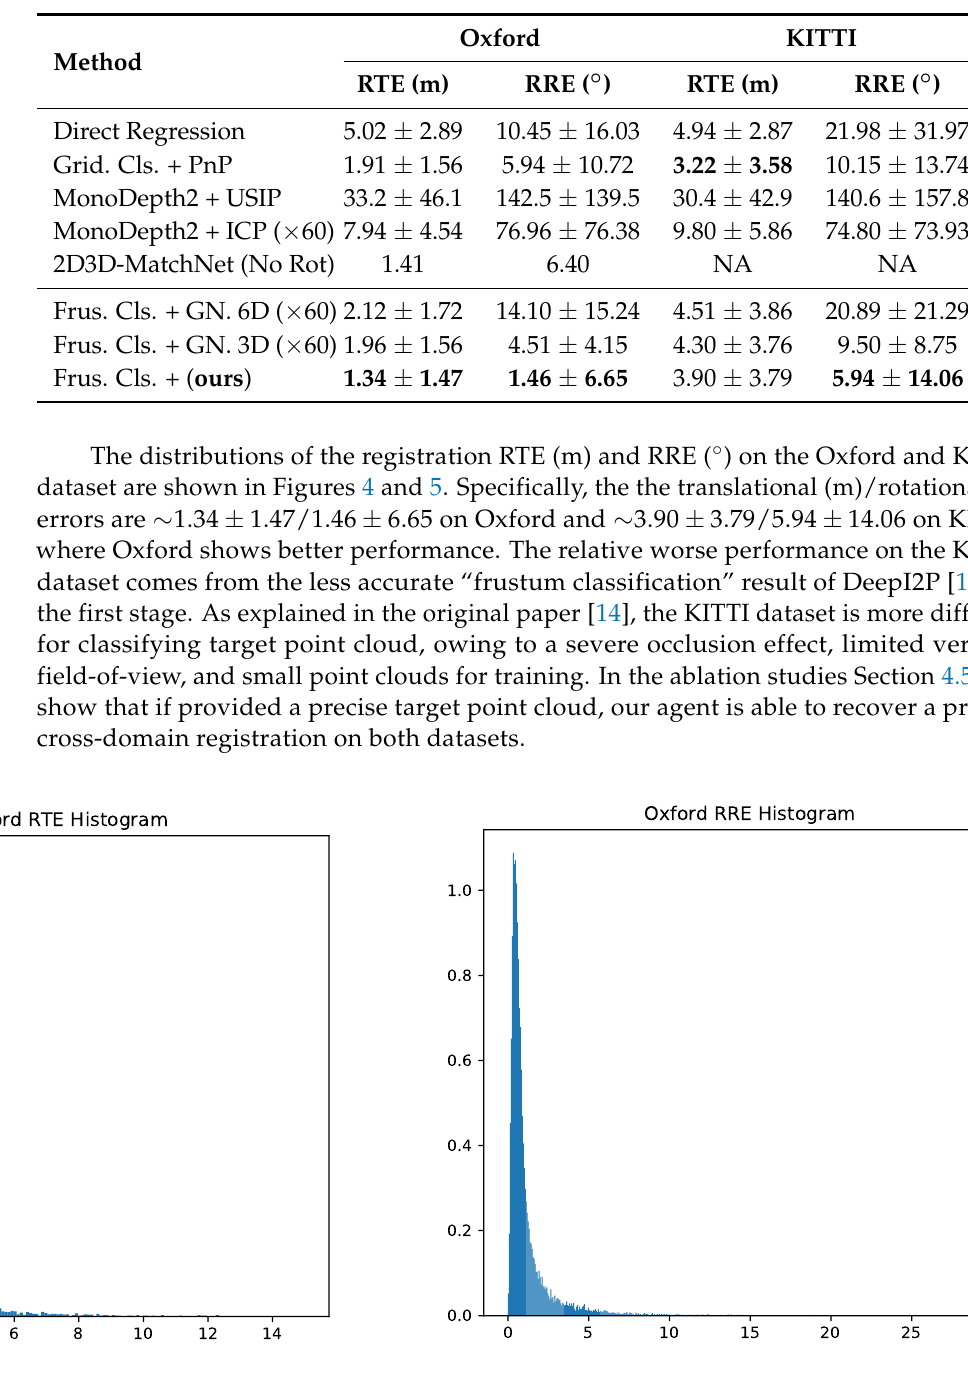
Table 2. Registration accuracy evaluation on both Oxford and KITTI datasets. The average value and standard deviation of RTE and RRE are reported. The Frus. Cls. represents the result of “frustum classification” provided by DeepI2P [14]. The GN. 6D and GN. 3D indicate the Gauss–Newton solver with 6-DOF and 3-DOF, respectively. The × 60 corresponds to 60 times with randomly generated initialization. Ours refers to the provided BC + RL algorithm. The best results are shown in bold.